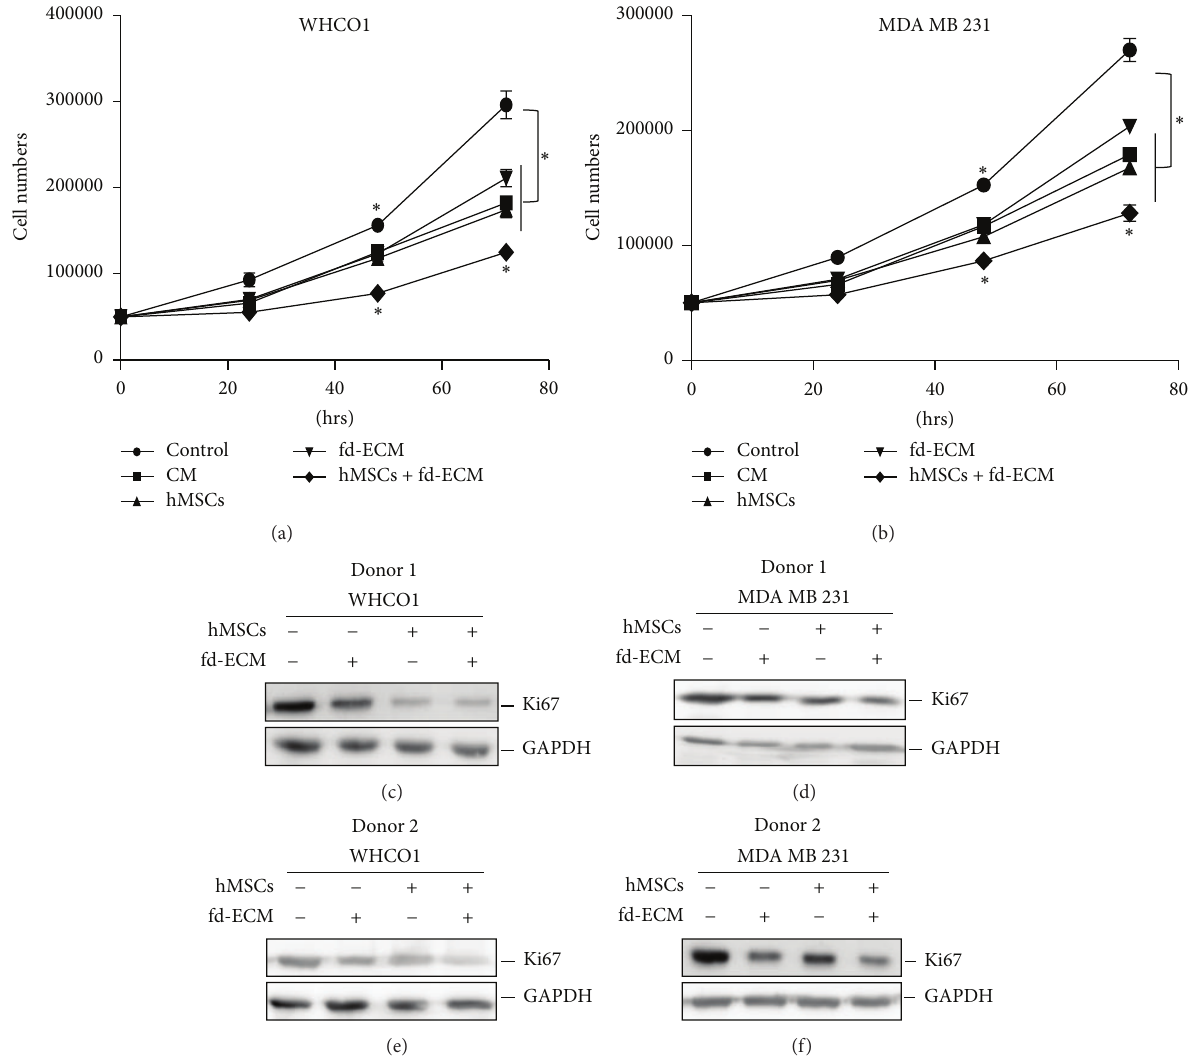
Figure 4: MSCs and the fd-ECM synergistically inhibit cancer cell proliferation. WHCO1 (a) and MDA MB 231 (b) cancer cells were cocultured with MSCs, cultured on fd-ECM, or in combination for the indicated time period. Control and treated cells were counted at the indicated times as described in Section 2. ((c)–(f)) Western blot analysis of cell lysates from control and treated WHCO1 and MDA MB 231 cells analyzed after 48 hrs of incubation using Ki67 antibody. Results obtained using MSCs from 2 donors are shown and are representative of all results obtained using WJ-MSCs from several other donors. Glyceraldehyde 3-phosphate dehydrogenase (GAPDH) was used as a loading control. Experiments were performed in triplicate and repeated 3